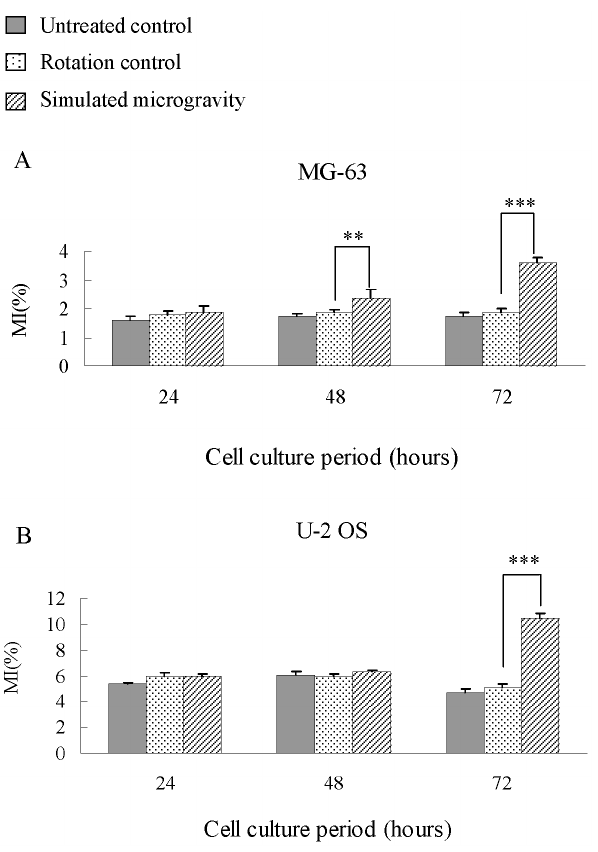
Figure 2. Mitotic index of MG-63 and U-2 OS cells under simulated microgravity. Significant increases in MI along with simulated microgravity duration, and significant difference resulting from being cultured for 48 and 72 hours in MG-63 (A) and 72 hours in U- 2 OS (B). The data shown represent the mean 6 S.E. (n = 3). *0.01 , P , 0.05, ** P , 0.01, and *** P , 0.001 ( x 2 -test as compared to rotation control group).